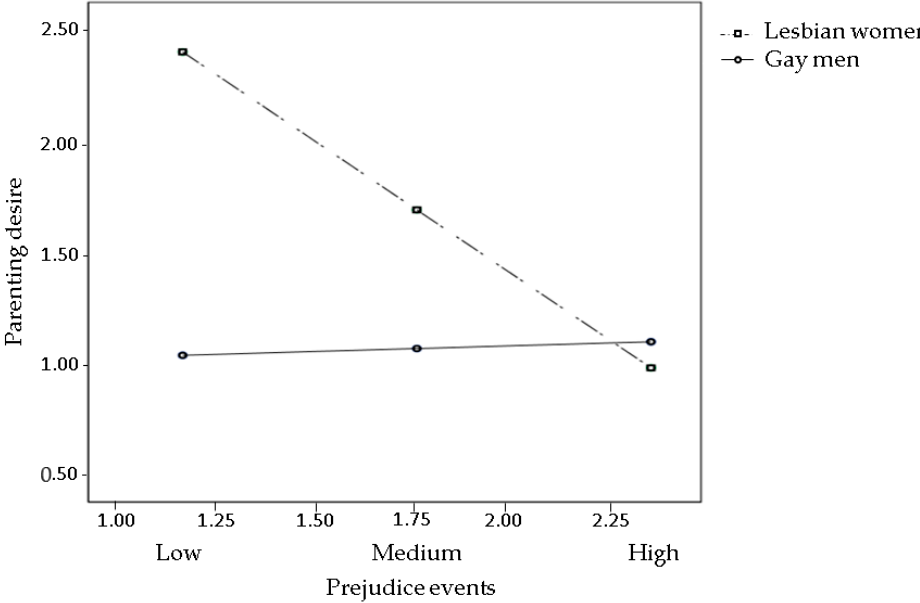
Figure 2. Interaction between prejudice events and gender on parenting desire. Estimated log odds of parenting desire are reported for combinations of prejudice events (low, medium, and high) and individual’s gender (lesbian women vs. gay men).